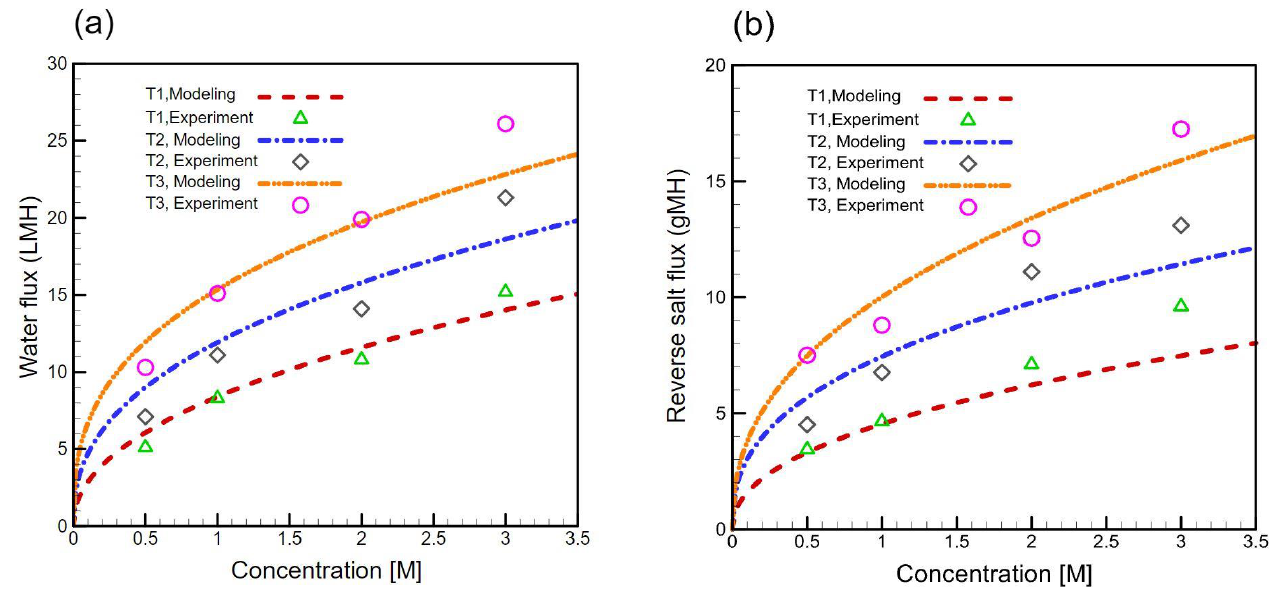
Figure 9. Comparison of computational fluid dynamics (CFD) model and experimental ( a ) water flux ( J w ) and ( b ) reverse salt flux ( J s ) water flux and RSF results to validate the accuracy of experimental data.